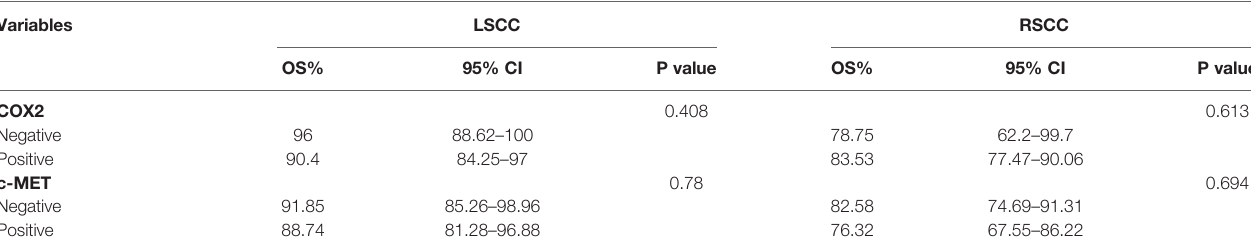
TABLE 3 | Multivariate Cox regression analyses of risk factors associated with overall survival in LSCC. Variables